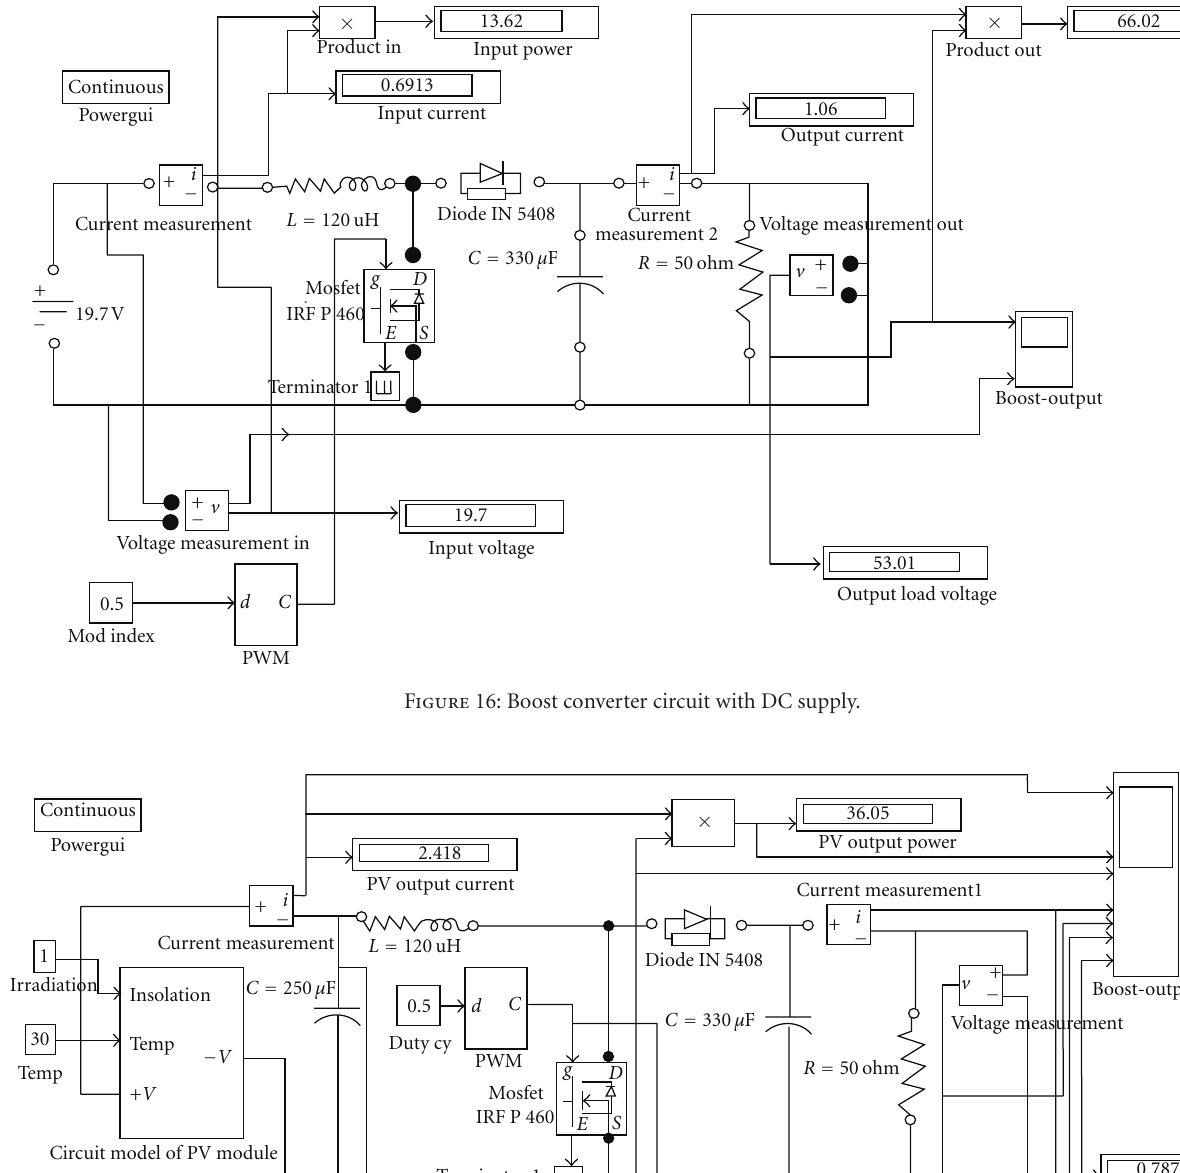
Figure 17: Boost converter circuit with PV